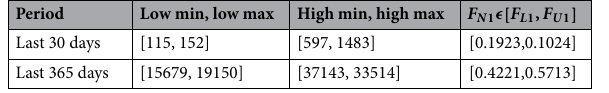
Table 1. U.S daily records.